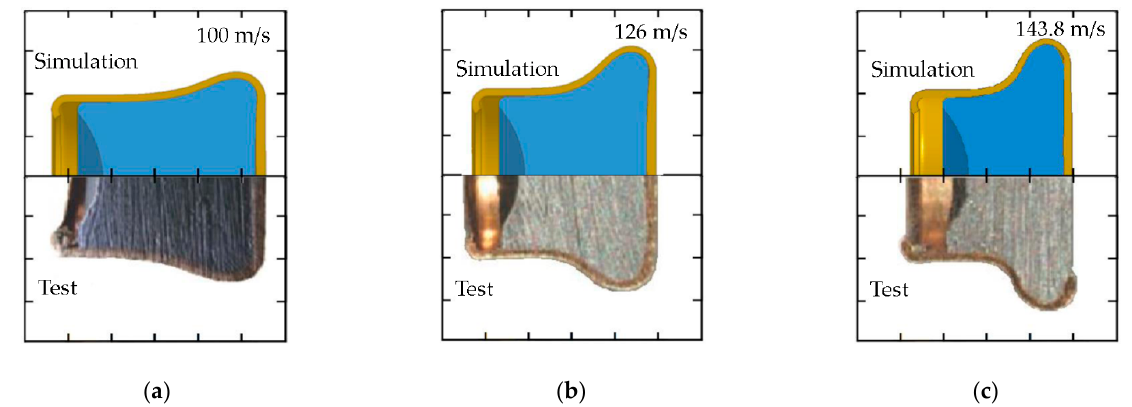
Figure 8. Deformations of the 9 mm FMJ Parabellum projectile obtained in the experiments and simulations: ( a ) impact velocity of 100 m/s; ( b ) impact velocity of 126 m/s and ( c ) impact velocity of 143.8 m/s.